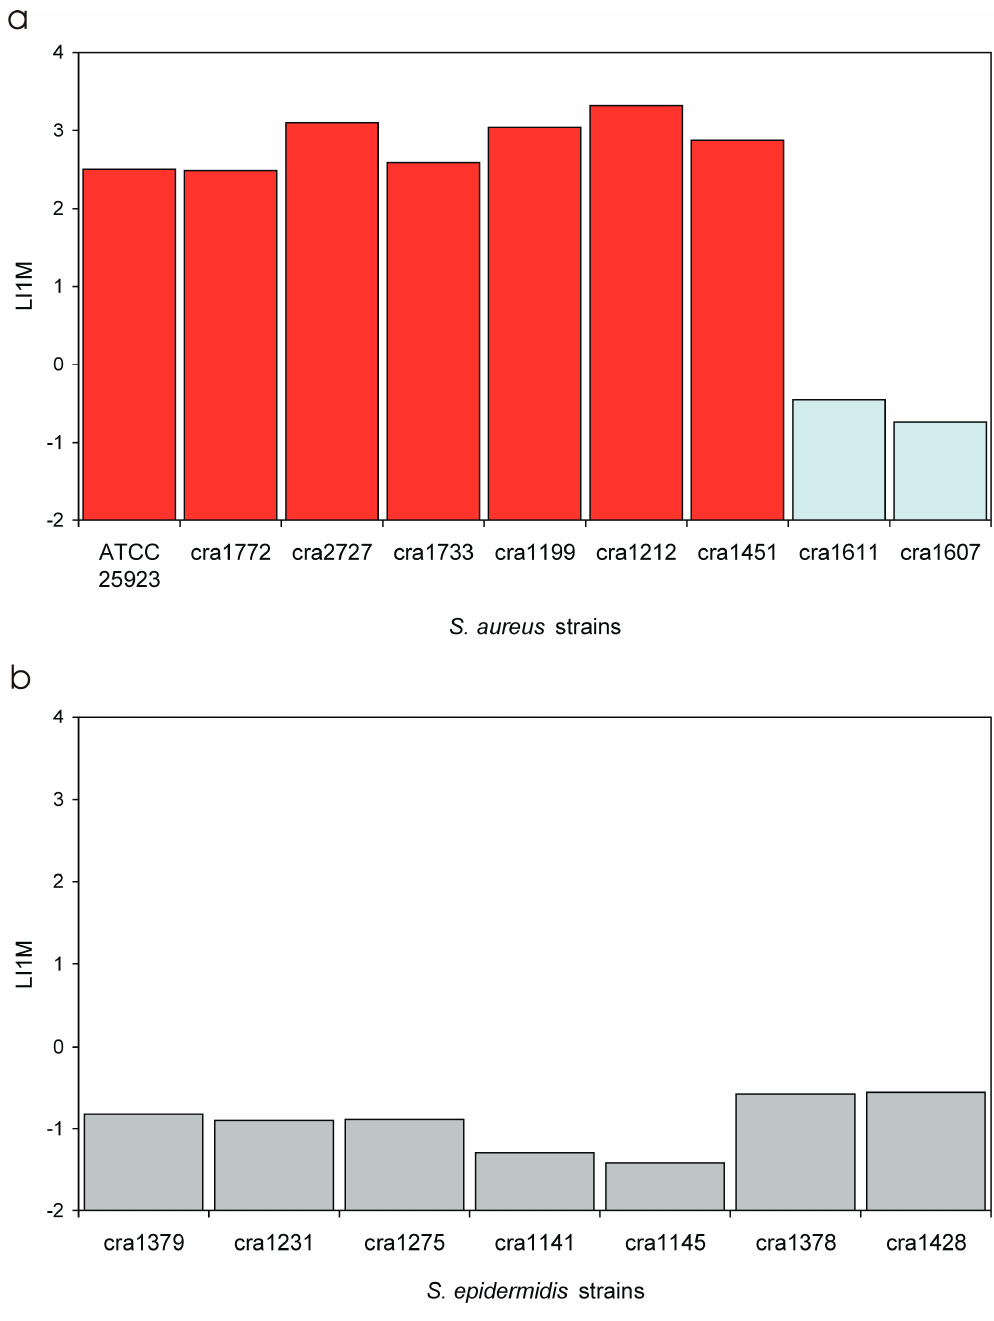
Figure 6. Bacterial invasiveness expressed in terms of LI1M: ( a ) LI1M value calculated for each S. aureus strain (HI S. aureus strains are in red, while LI strains are in light blue); and ( b ) LI1M value calculated for each of the seven S. epidermids strains.